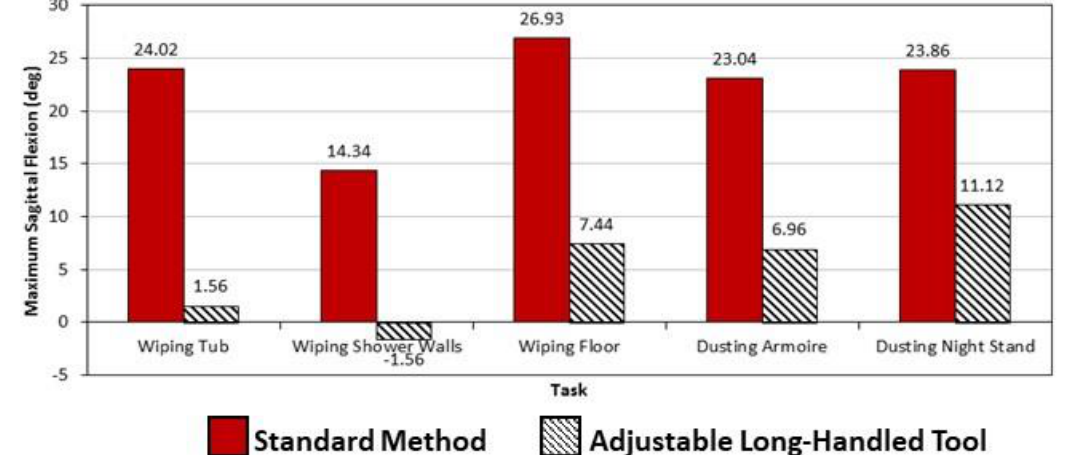
Figure 4. Differences in average sagittal flexion angles between cleaning methods of five bathroom and furniture cleaning methods. All were significantly different ( p < 0.05).